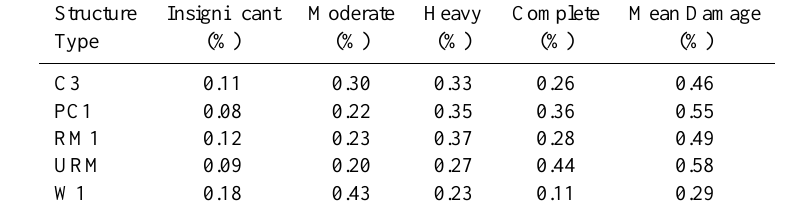
Table 6. Results of earthquake damage analysis for the buildings, with different damage states with respect to structure types.